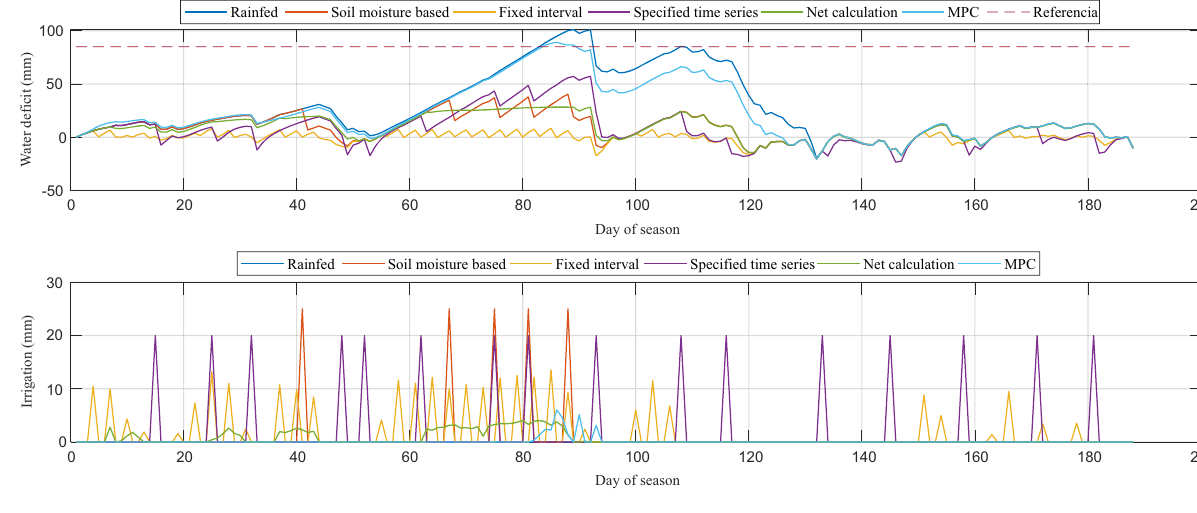
Figure 10: Comparison of the results of the irrigation methods for the Year